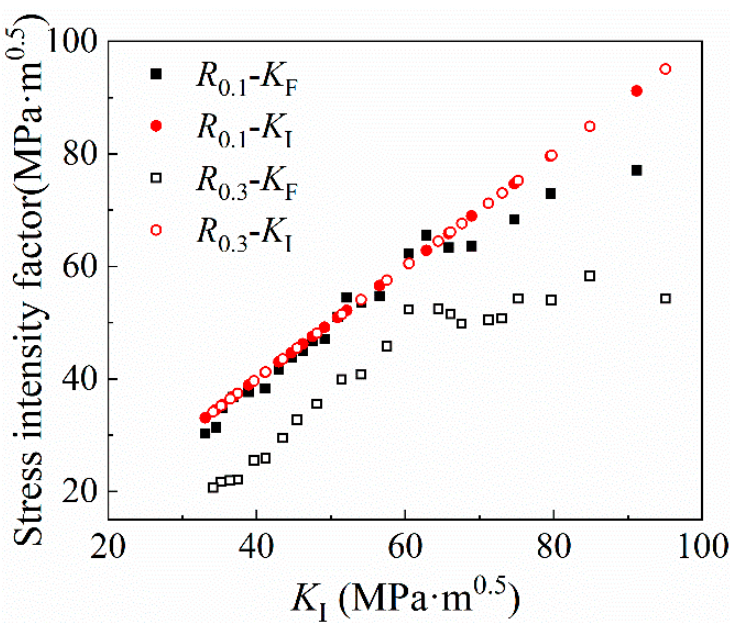
Figure 10. The variation of SIF K F with traditional SIF K I.